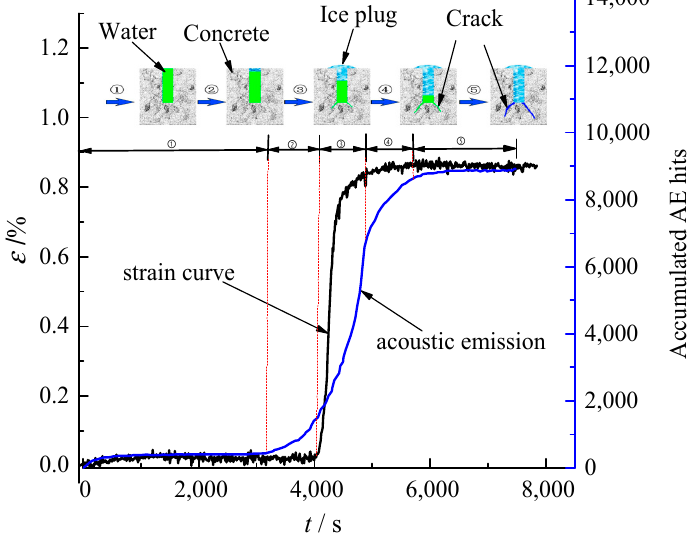
Figure 6. Schematic diagram of the process of frost-heave crack propagation for specimen A1.